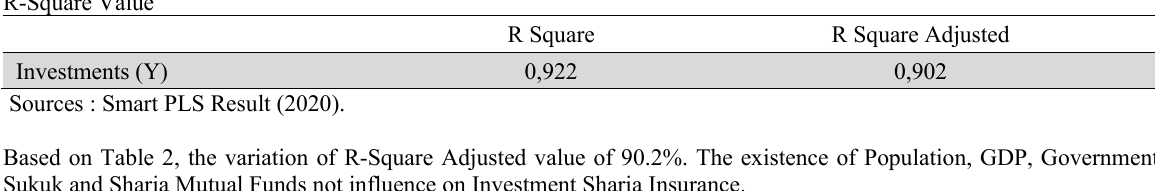
R-Square Value Investments (Y) 0,922 0,902 Sources : Smart PLS Result